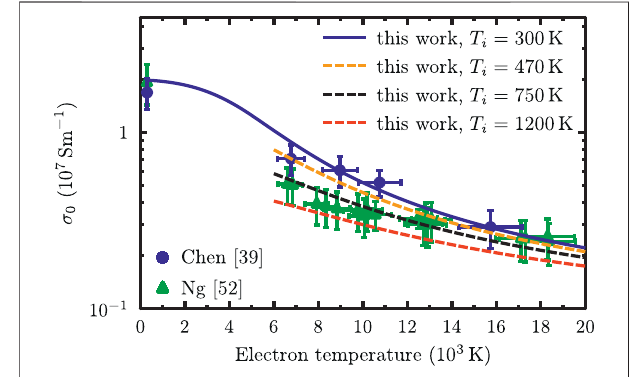
FIGURE 4 | Temperature-dependent DC electrical conductivity of gold. The calculations according to Eq. 6 are shown for different phonon temperatures and compared with data from THz transmission measurements [39] (blue circles) and optical pump-probe experiments [52] (green